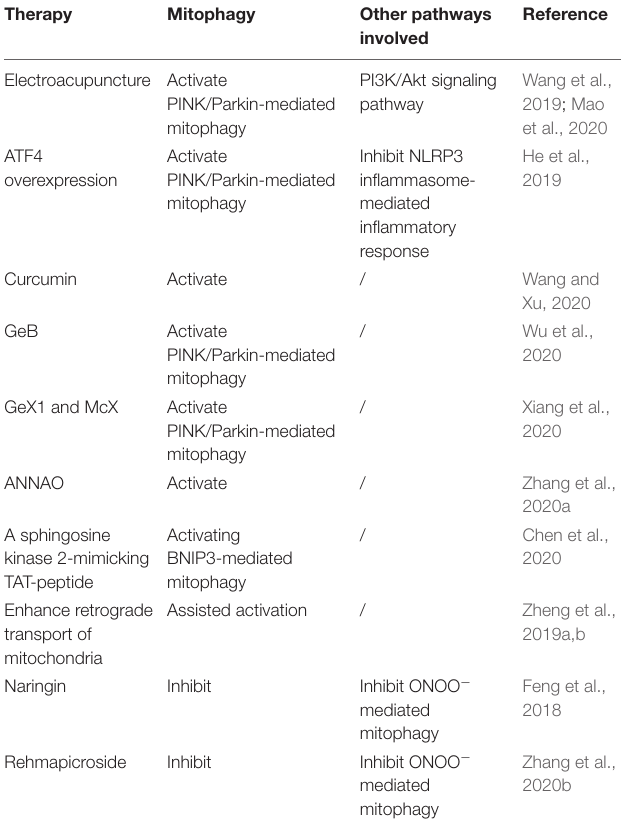
TABLE 1 | Summary of Part 3.4 Therapeutic potential of mitophagy in I/R